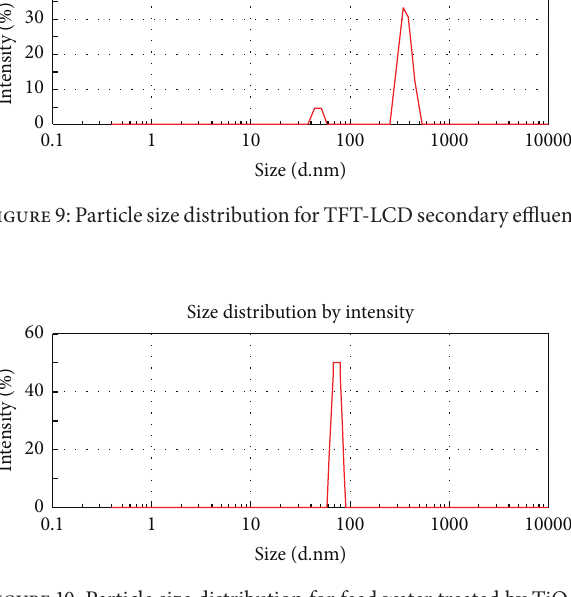
Figure 10: Particle size distribution for feed water treated by TiO 2 - film photocatalysis (5 coating